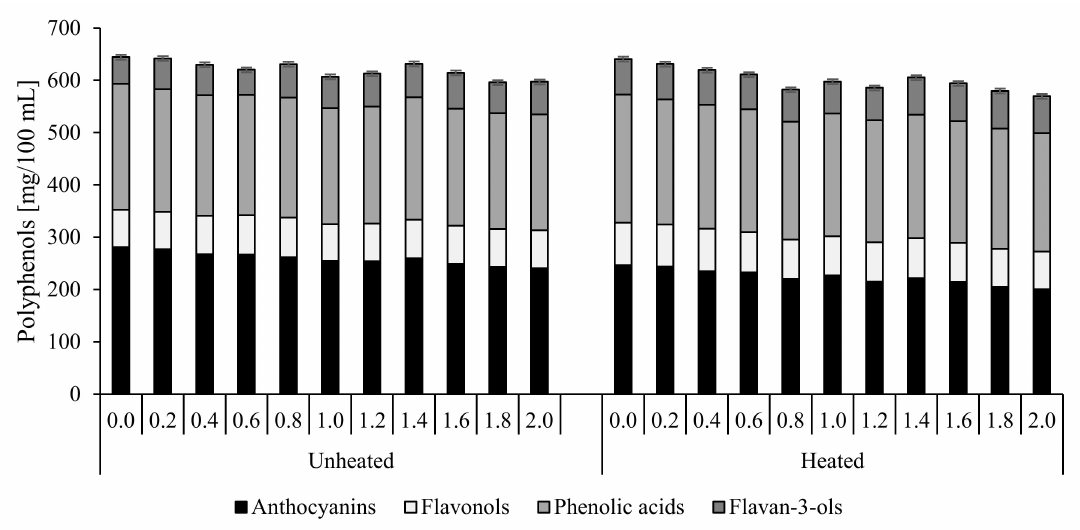
Figure 6. Polyphenolic content in the cranberry juice with CESP before and after thermal